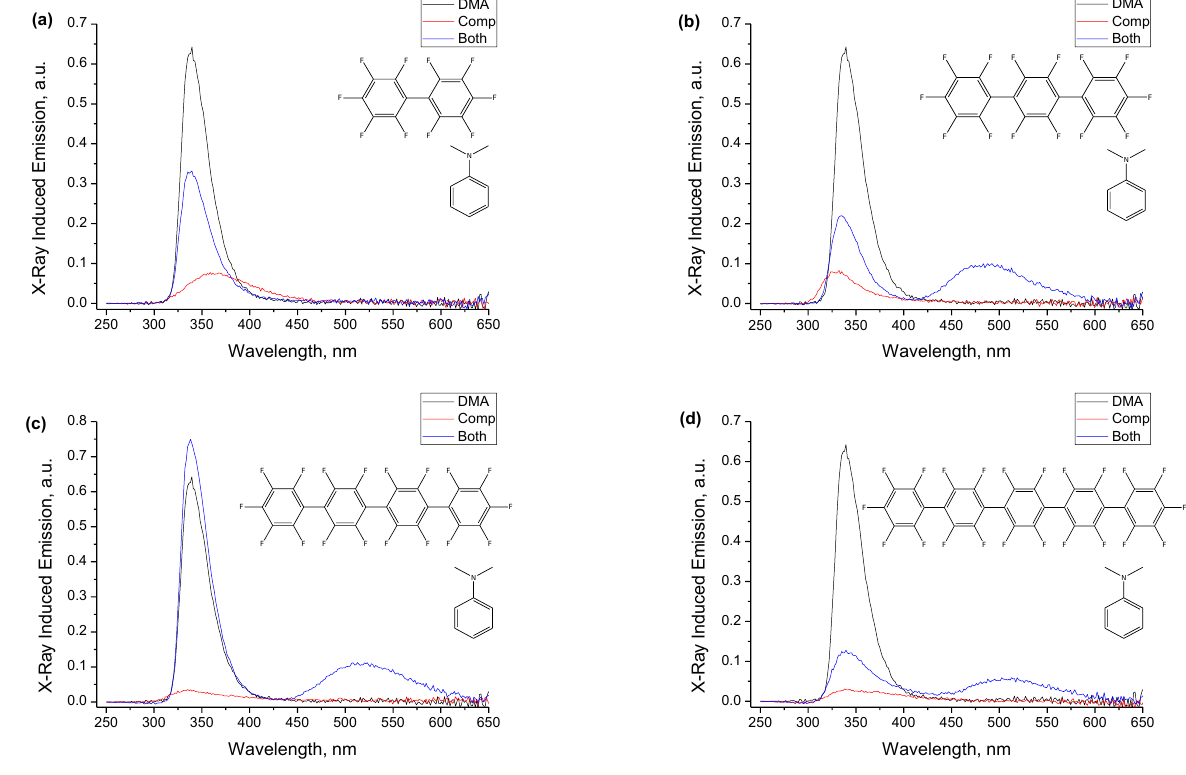
Figure 3. Spectra of X-ray-induced luminescence for the four compounds (( a )— 1 , ( b )— 2 , ( c )— 3 , ( d )— 4 ) in degassed n -dodecane solutions. Each panel shows a group of spectra from three samples: only DMA (black curve), only the compound (red curve), and their mixture at the same concentrations of the components (blue curve). The DMA concentration in all samples is 10 −2 M. Concentrations of compounds (with the exception of 1 ) are limited by their solubility in n -dodecane and are: 5 × 10 −3 M for 1 , 1.8 × 10 −3 M for 2 , 4.4 × 10 −4 M for 3 , 1.1 × 10 −4 M for 4 .